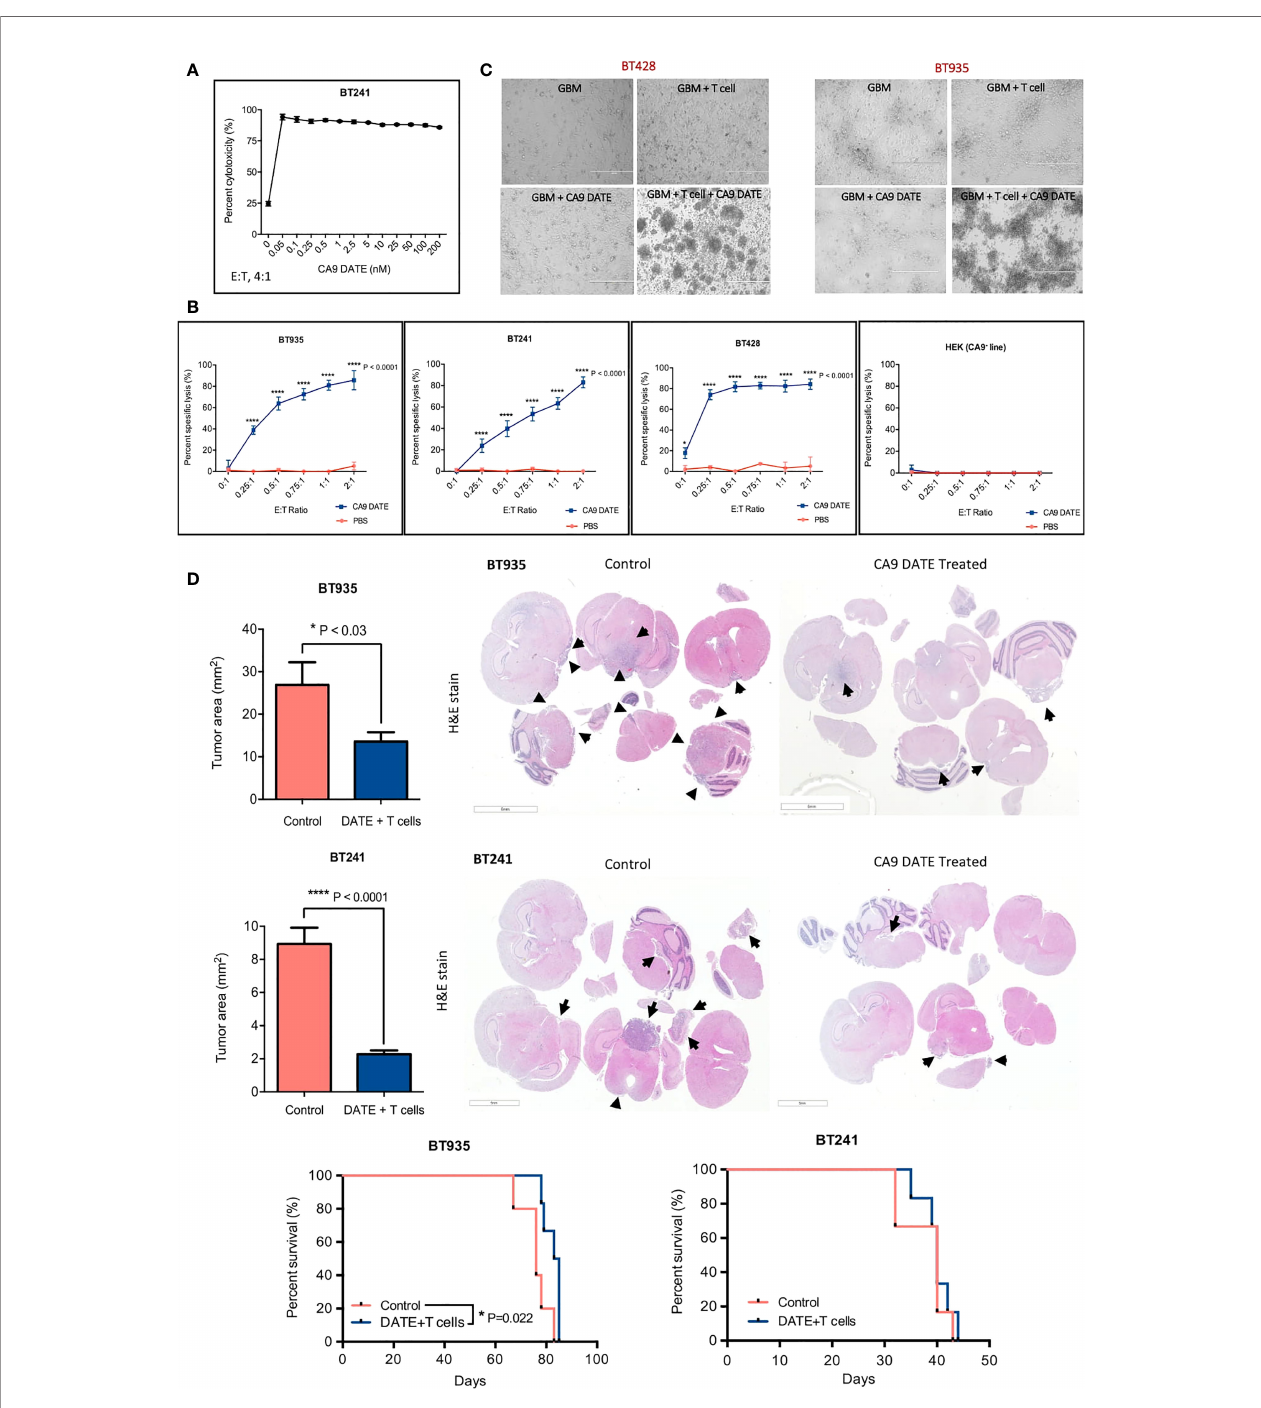
FIGURE 6 | Therapeutic targeting of CA9hi GBM BTICs using CA9 DATEs at in vitro level and in patient derived xenograft model of GBM. (A) Dose response study performed on BT 241, CA9hi GBM BTIC, identi fi ed 1 nM as the optimal dose for GBM cytotoxicity assay. (B) DATEs signi fi cantly induced cytotoxicity of CA9hi GBM BTICs (BT241, BT935, BT428) but not CA9- cells (HEK) when co-cultured with T cells and DATEs (1n M) for 16 hours at different E:T ratios. (n=3) (P value:*< 0.05, **** < 0.0001) (2 way ANOVA). (C) Micrographs of GBM BTICs and T-cell co-culture with and without DATEs. CA9hi GBM BTIC lines (BT 935 and BT 428) were incubated with either T cells (E:T ratio, 1 :2) or CA9 DATE alone or with both. GBM BTIC lysis were observed only in the presence of both T cells and CA9 DATEs (Scale bar: 400 m). (D) NSG mice were intracranially implanted with human CA9hi GBM BTICs (BT935 and BT241). Upon successful engraftment, mice were intracranially treated with 1x10 6 T cells isolated from human PBMCs either with CA9 DATE or CA9 DATE control (50µg = 667nM) for a total offour doses over two weeks. Mouse xenografts generated after CA9 DATE treatment had less tumor burden (n=6) (P value: * < 0.03, **** < 0.0001) (mean±SEM, two-tailed t-test) and maintained a signi fi cant survival advantage over control mice in BT935 engrafted mice (P value: * < 0.03) (Log-rank Mantel-Cox Test); however, DATE treatment on BT241 engrafted mice only showed increased pattern of survival